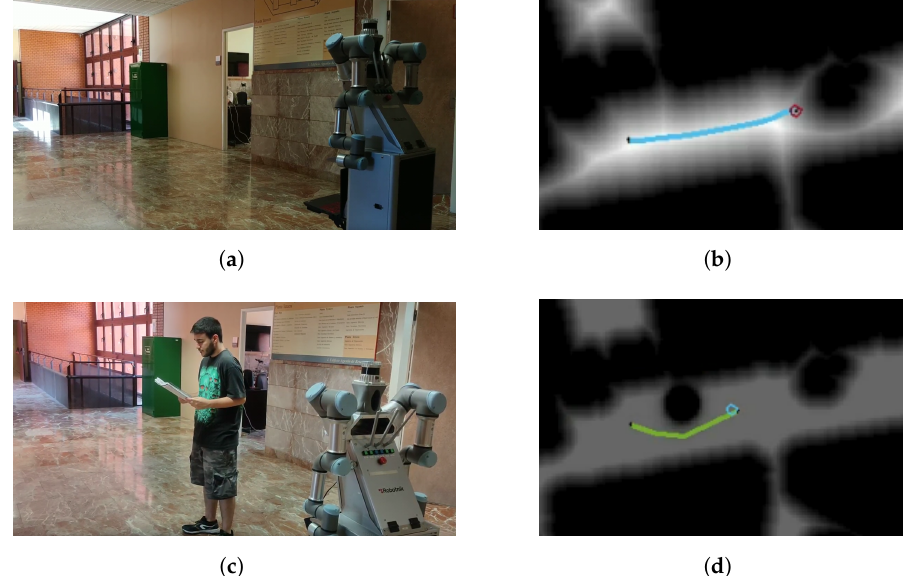
Figure 27. Social navigation example of the robot in a real scenario with a person. ( a ) Initial scenarios without people; ( b ) initial planned path; ( c ) person detection in front of the robot, standing in the initial path; ( d ) path replanning considering the personal space of the person.